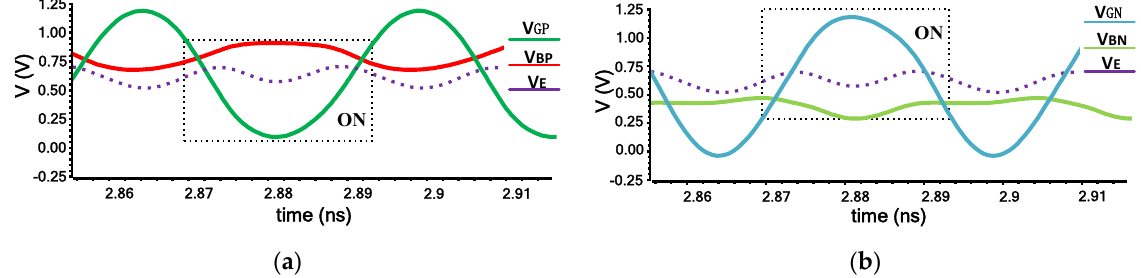
Figure 6. Transient simulation of gate, bulk and central tap: ( a ) PMOS and ( b ) NMOS.